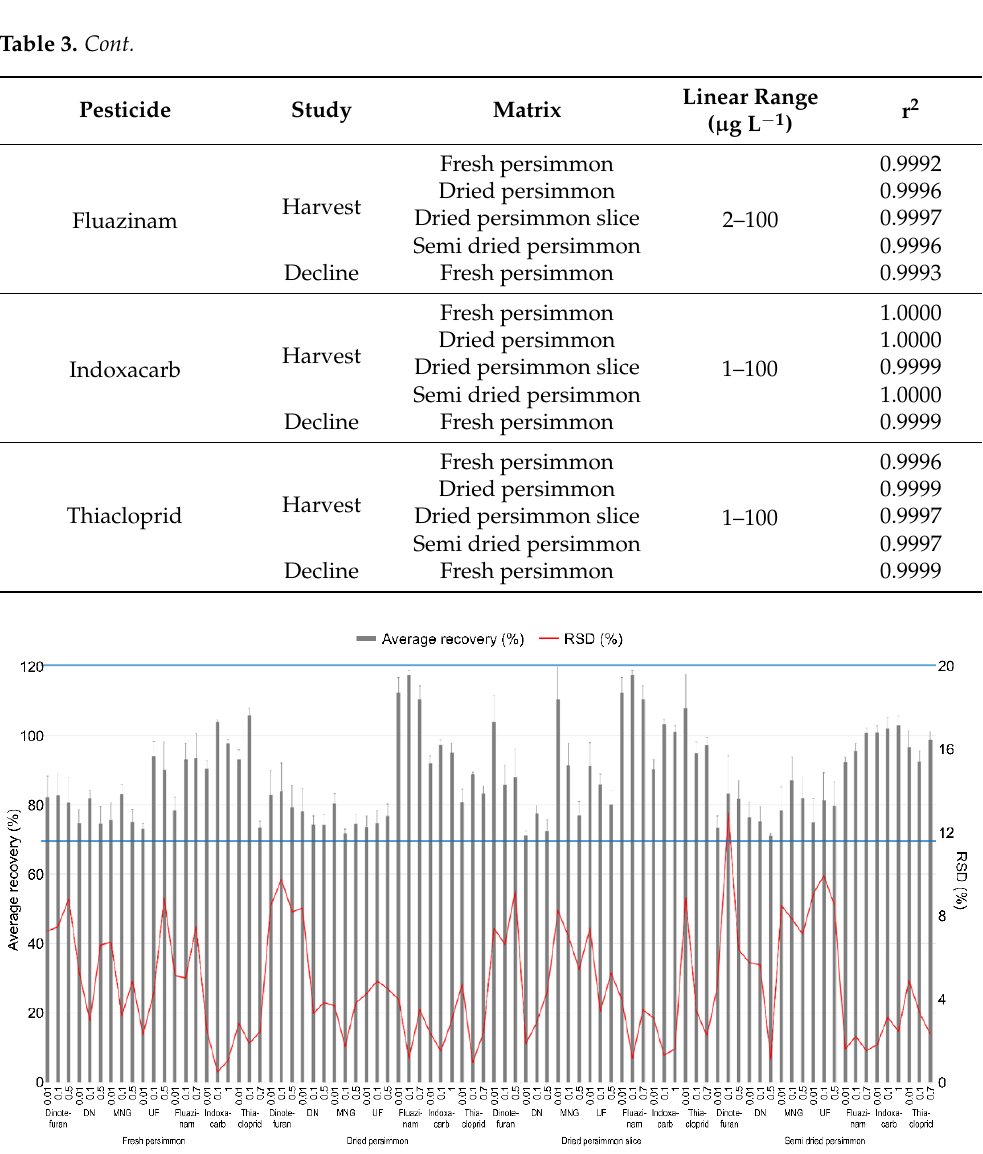
Figure 4. Recovery and RSD of test pesticide in fresh persimmon and its processed products for the validation of the analysis method. The effective range of the recovery is indicated by the blue line.